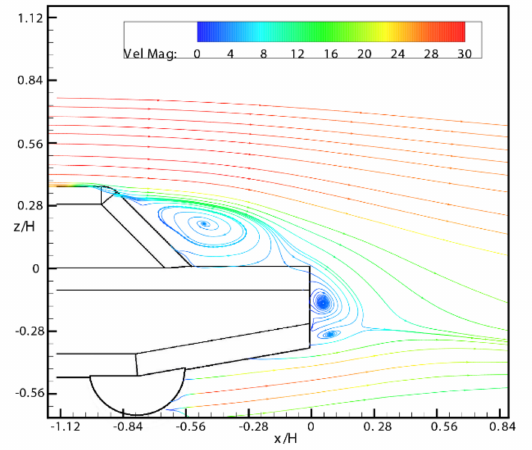
Figure 18. Time-averaged velocity streamline in x–z plane at y/H = 0, colored with velocity magni- tude (Vel Mag, m/s).